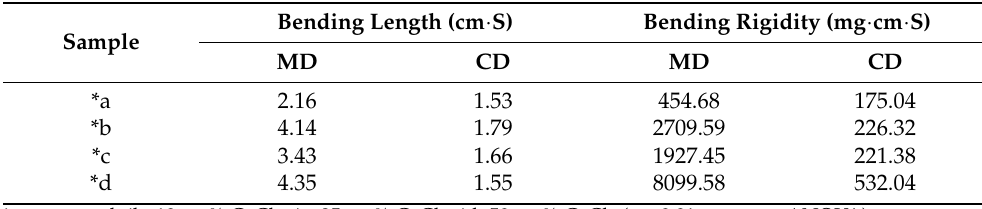
Table 2. Bending length and bending rigidity